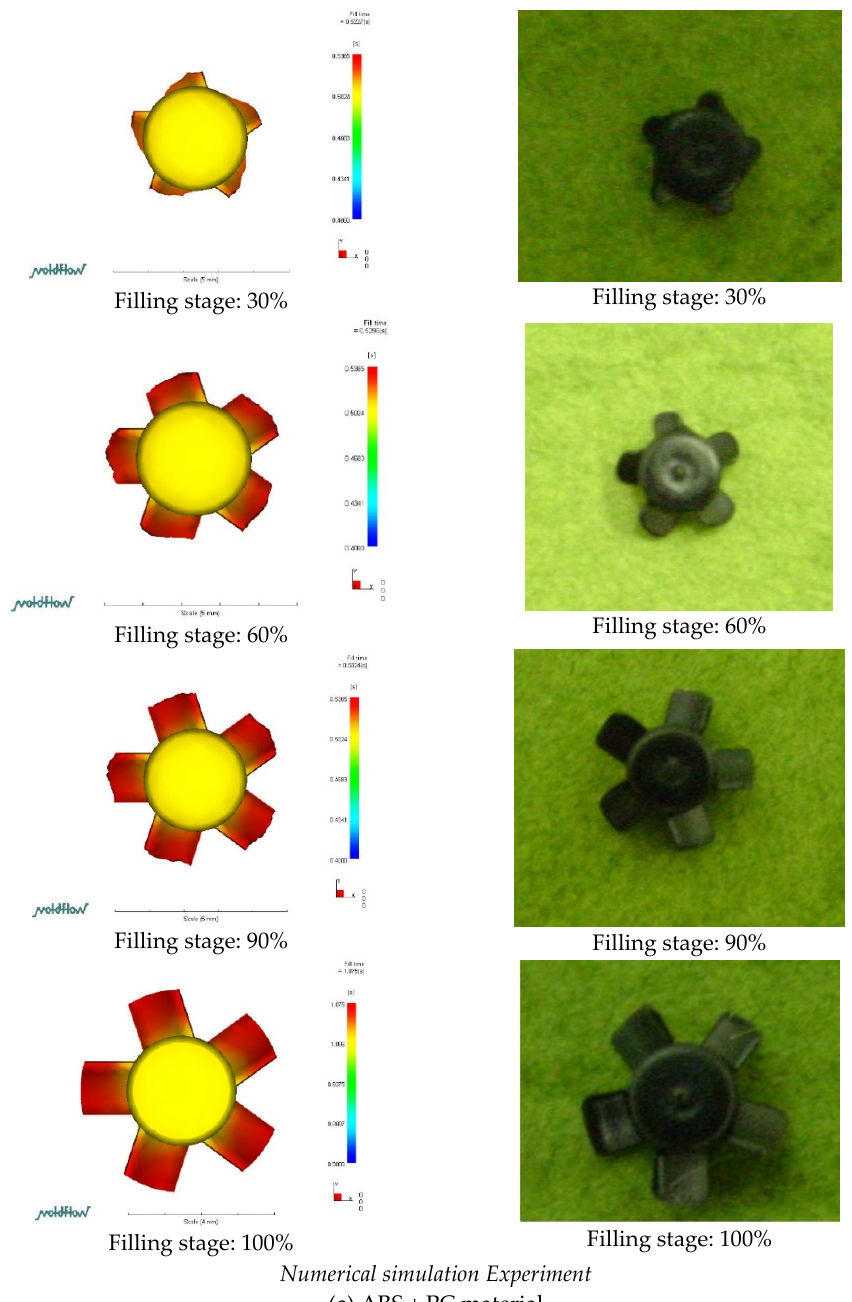
Figure 6. Short shot of micro-sized part with POM/ABS/PP/PA/ABS + PC material on PIM. ( a ) POM material; ( b ) ABS material; ( c ) PP material; ( d ) PA material; ( e ) ABS + PC